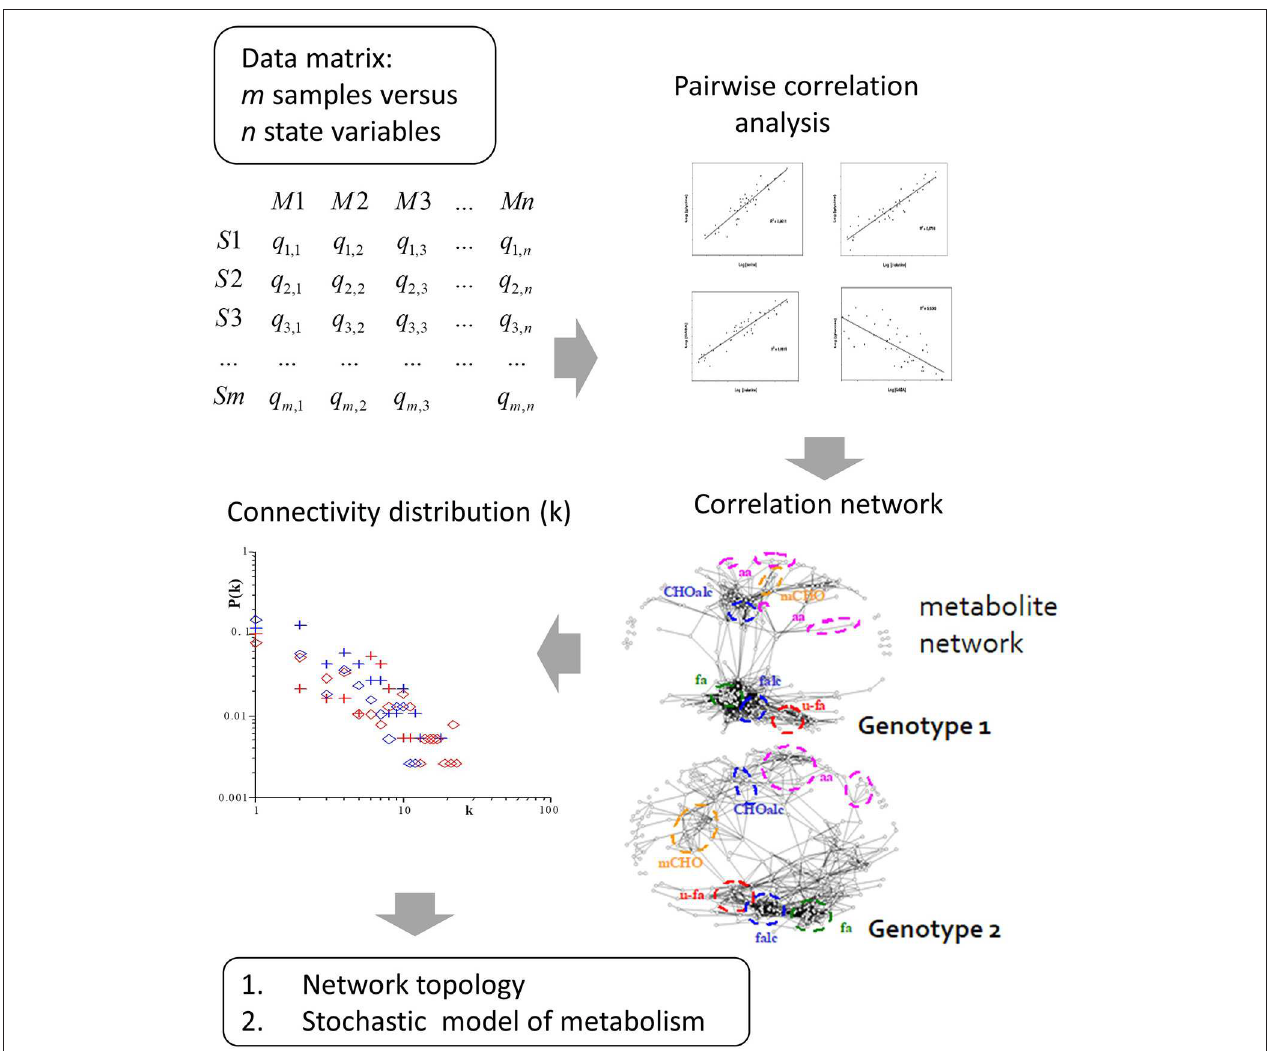
FIGURE 2 | Derivation of metabolite correlation networks from large-scale metabolomic analysis. These correlation networks show differential connectivity in dependence of the analyzed genotype. From this fundamental multivariate structure several research fields are envisioned: Firstly, topology analysis of the correlation network resulted in a power-law-like pattern of the probability of metabolite connectivity [ 34, 35]. The power-law pattern is observed in real world networks with only a few hub nodes showing high connectivity in contrast to most others. This pattern is also highly conserved in biochemical networks, thus reflecting biochemical network structure and regulation. Secondly, based on the correlation pattern we developed a stochastic model of metabolism which led to the stochastic Lyapunov matrix equation (for more details see